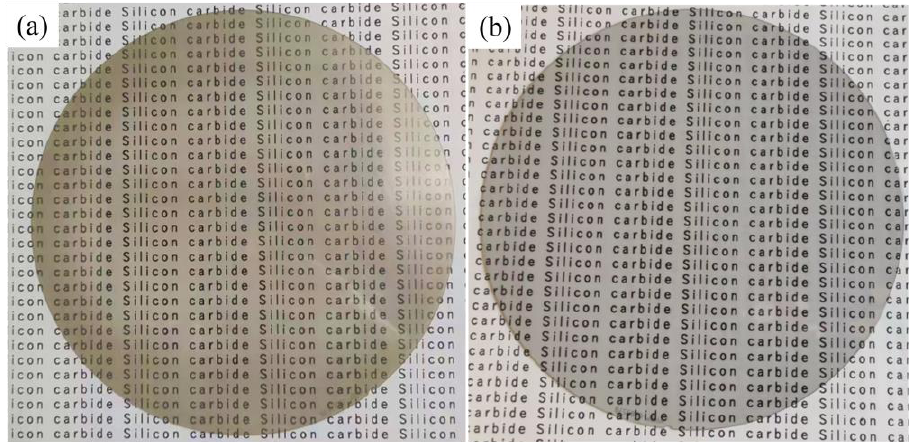
Figure 11. Si surface of 4H-SiC wafer before and after polishing: ( a ) original surface; ( b ) after pol- ishing.